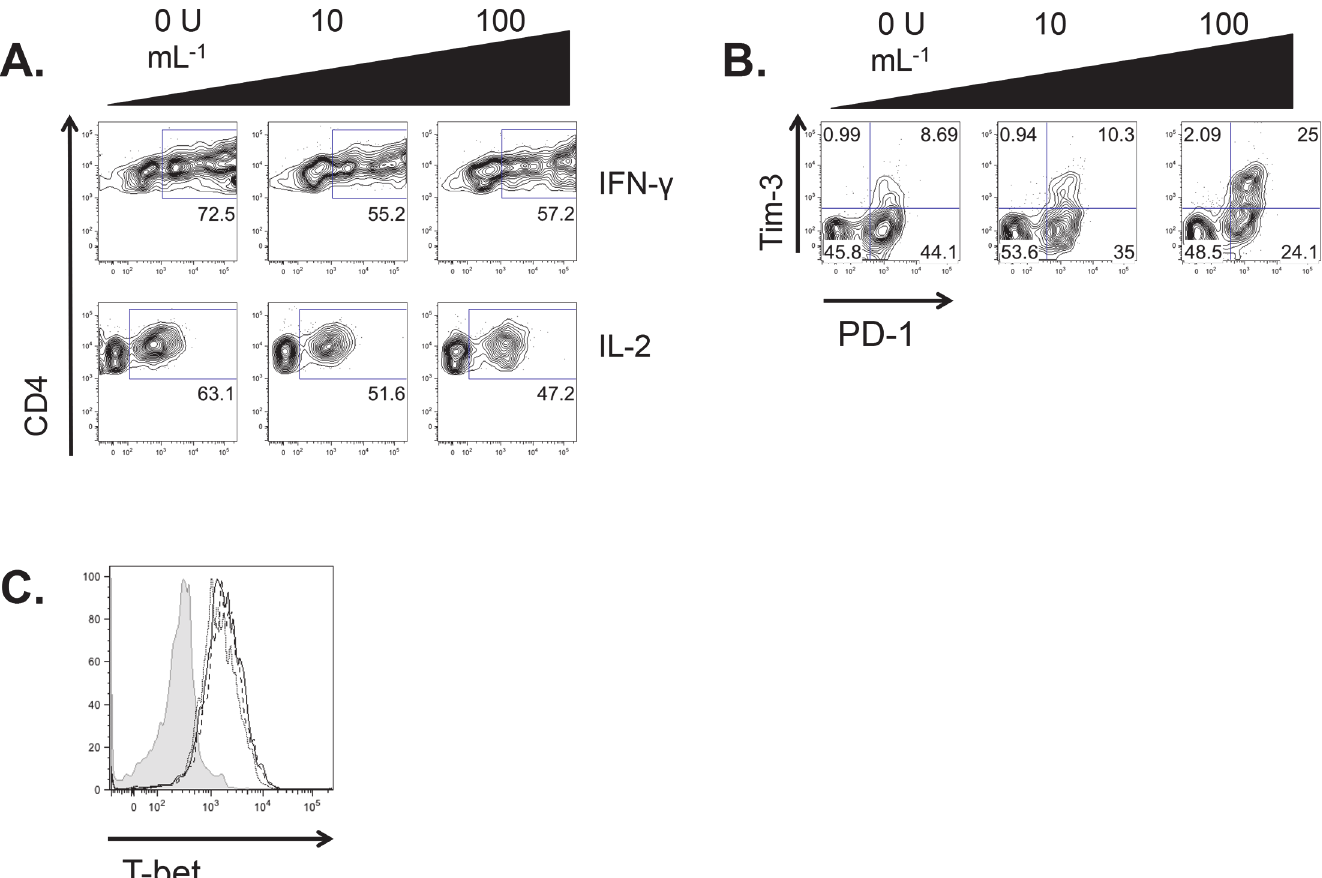
Fig 4. IFN- β suppresses cytokine secretion from Th1 cells. A. CD4 + CD62L hi T cells were sorted from the spleens and lymph nodes of C57BL6/J mice and were stimulated with plate-bound anti-CD3+anti-CD28 under Th1 conditions, with the indicated concentrations of IFN- β , for 5 days. Cells were restimulated for 48 hours under Th1 conditions with the same concentration of IFN- β as at the initial stimulation. A. Generation of IFN- γ and IL-2 was assessed by intracellular cytokine staining and flow cytometry. Representative of three experiments. B. Expression of Tim-3 and PD-1 were assessed by flow cytometry. Representative of three experiments. C. Expression of T-bet was assessed by flow cytometry. Representative data from one of three mice assessed individually. Solid line with open histogram, Th1; dashed line with open histogram, Th1 + 10 U mL -1 IFN- β ; dotted line with open histogram, Th1 + 100 U mL -1 IFN- β ; shaded histogram, FMO control. Data in all panels gated on CD4 + cells.